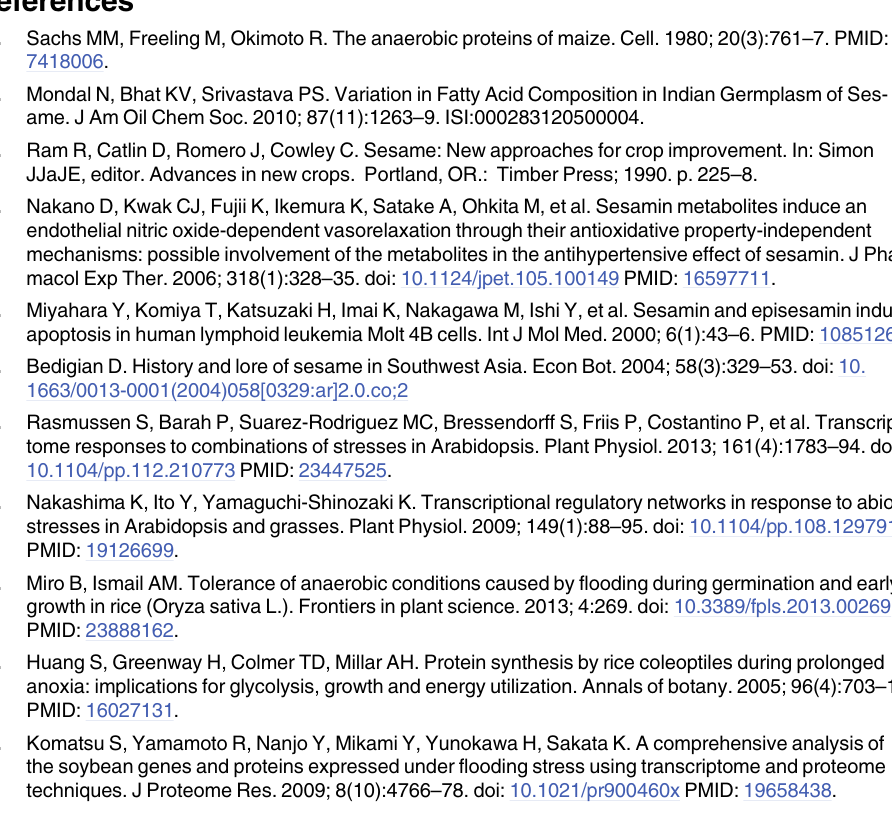
S8 Table. 276 homologous stress-responsive genes differentially expressed in both WT and WS plants post-drainage. S9 Table. List of the 39 core hormone homologous genes responsive to waterlogging in ses- ame. S10 Table. List of the 94 hormone homologous genes functioning post-drainage in sesame. (XLSX) S11 Table. GO enrichment of the 66 common DEGs between WT and WS under waterlog- ging from 3 to